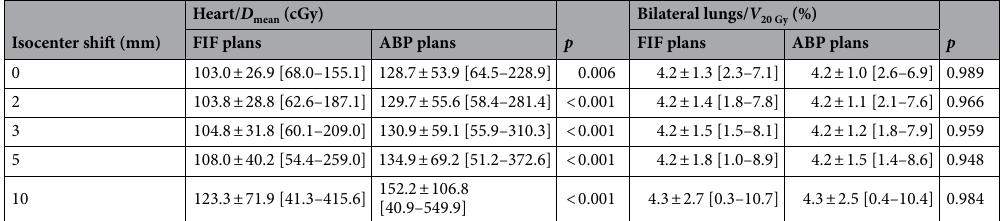
Table 2. Analysis of dose-volume data of the heart and bilateral lungs. D mean , mean dose; V x Gy , percentage volume receiving dose greater than x Gy; FIF, field-in-field technique; ABP, automated breast planning. Data are presented as the mean ± standard deviation [range]. The p values are from the paired t test.